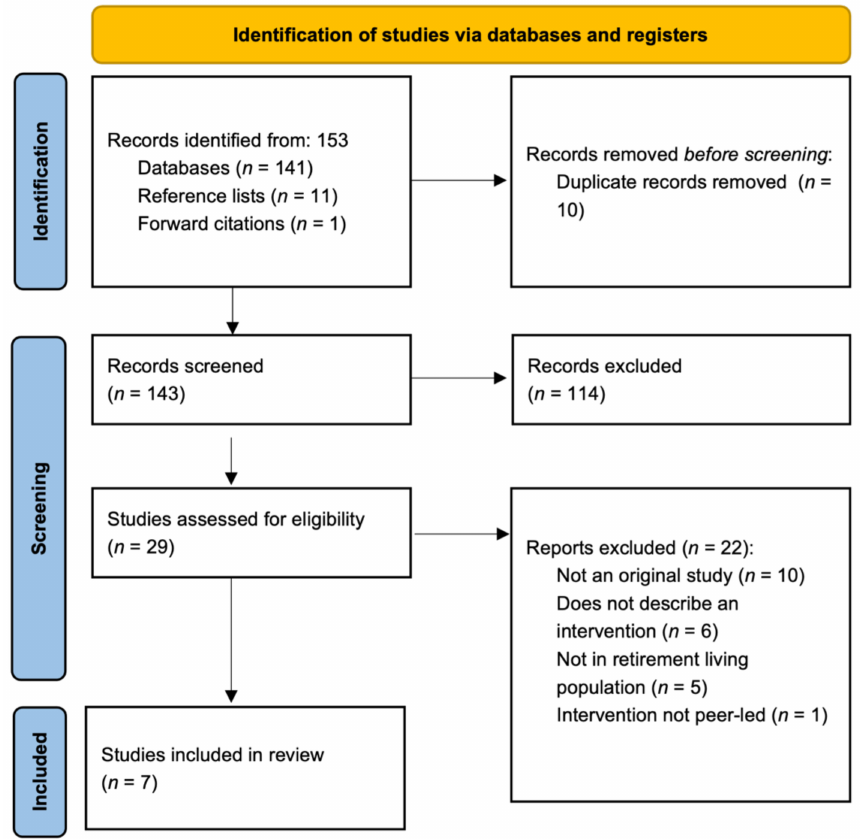
Figure 1. PRISMA flow